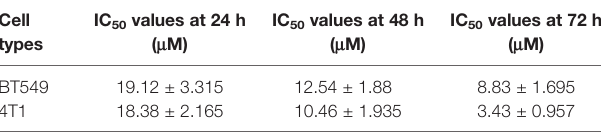
TABLE 1 | The IC 50 values of cordycepin in breast cancer cell